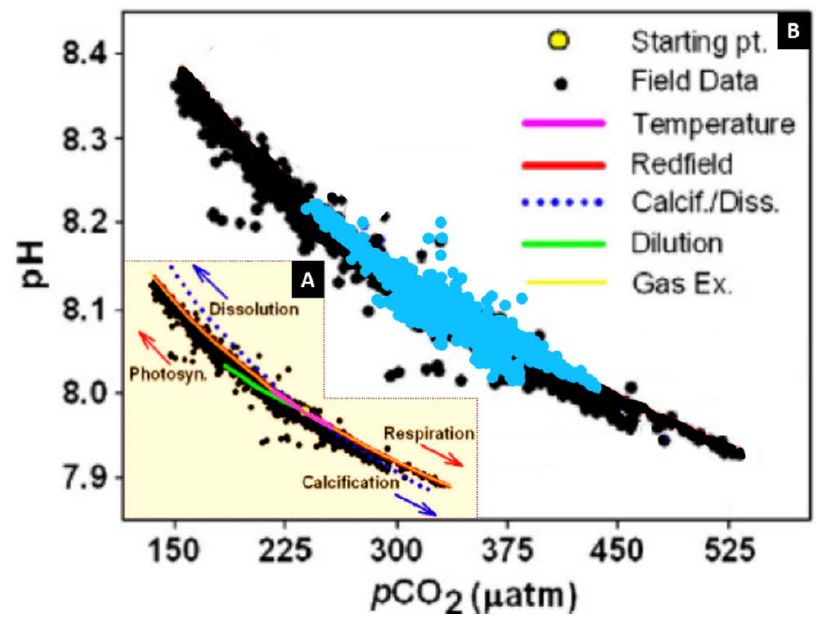
Figure 6. ( A ) Influence on the pH-pCO 2 relationship of various modelled processes. ( B ) pH versus pCO 2 for the D366 research cruise (blue dots) plotted over data reported by [64] and collected in Monterey Bay on the MBARI M0 buoy in summer 2007 (black dots). For biological production and respiration (red curve), DIC and TA were varied by the Redfield ratio 106:18 over the range TA = 2243–2289 μmol kg − 1 and DIC = 1824–2094 μmol kg − 1 (T = 14.0 °C). Gas exchange (yellow curve) was calculated using a similar range for DIC, but keeping the TA constant (T = 14.0 °C). For calcification and dissolution (blue filled circles), DIC and TA were varied by 1:2 over the range TA = 2090–2770 μmol kg − 1 and DIC = 1950–2290 μmol kg − 1 (T = 14.0 °C). For changes in temperature (pink curve), DIC and TA were fixed at 2032 μmol kg − 1 and 2254 μmol kg − 1 , respectively, and temperature was varied over the range of the field data (11–16 °C). Dilution evaporation/precipitation green curve) was modelled by varying TA and DIC in a 1:1 ratio over the range TA = 1985–2254 μmol kg − 1 and DIC = 1763–2032 μmol kg − 1 . All calculations were centred on the initial conditions, S = 33.7, DIC = 2032 μmol kg − 1 and TA = 2254 μmol kg − 1 (yellow filled circle). Figure adapted from [64].